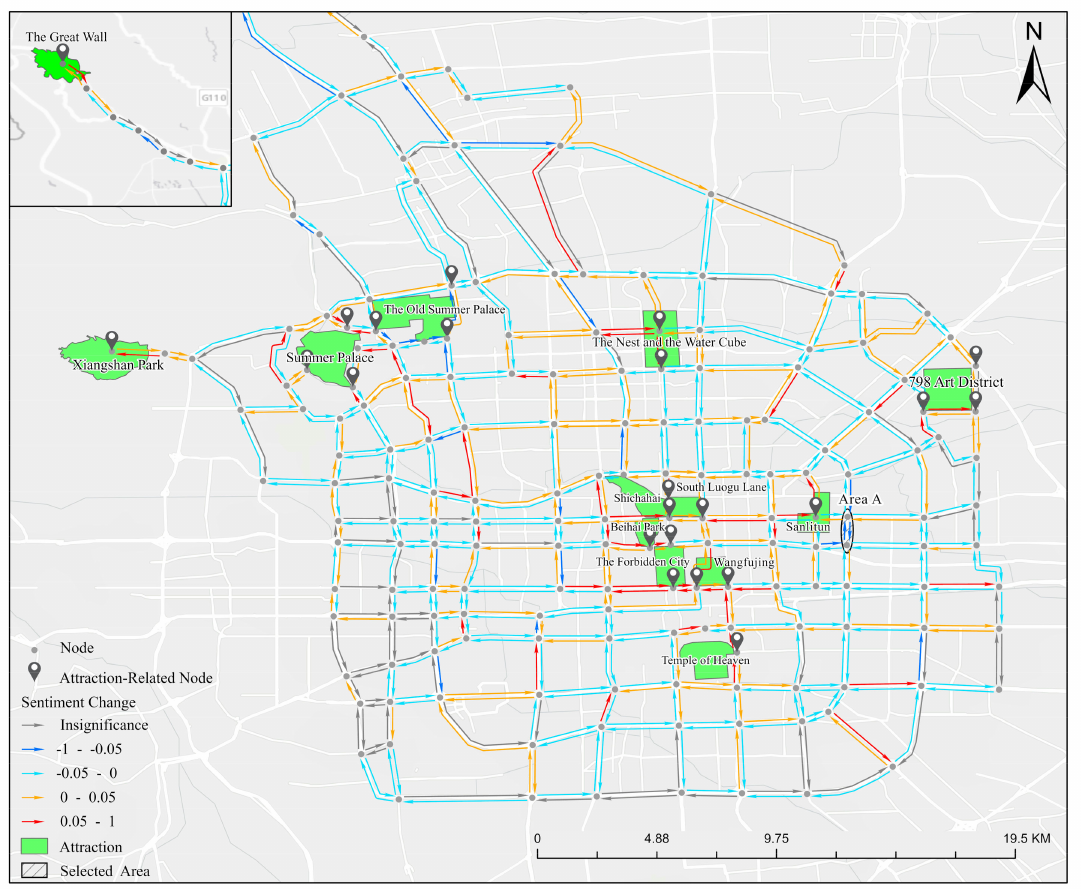
Figure 6. The spatial distribution of sentiment change in tourist flow in the